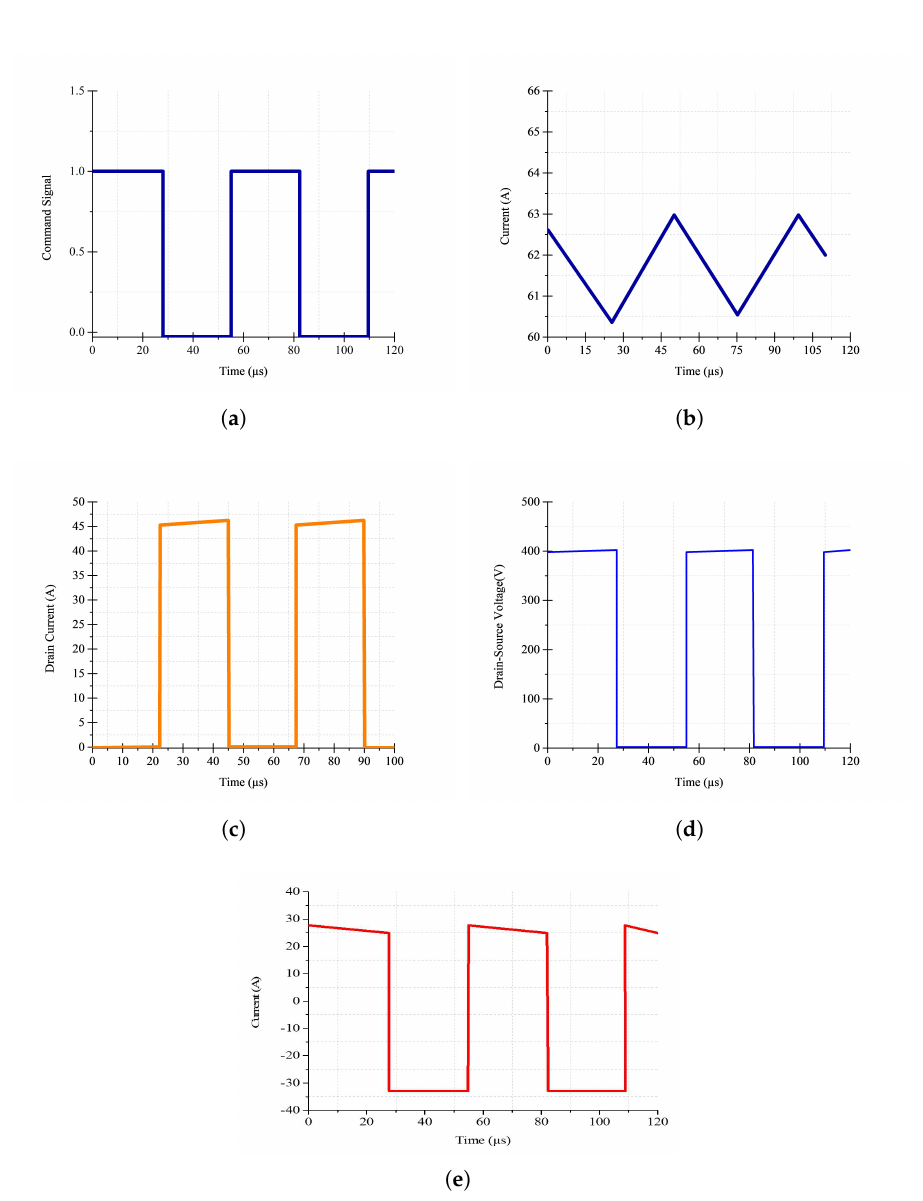
Figure 21. Key waveforms of SiC MOSFET (top to bottom: gate command signal, inductor ripple current, SiC drain current and voltage, and capacitor ripple current). ( a ) Gate signal, ( b ) inductor ripple current, ( c ) SiC MOSFET drain current, ( d ) drain voltage and ( e ) capacitor ripple